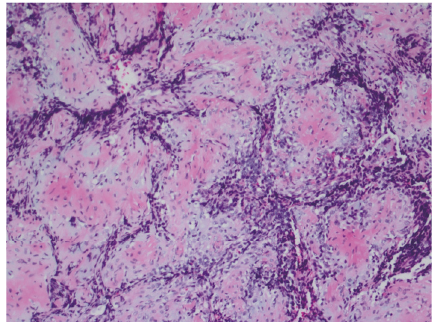
Figure 3: 10x magnification of chondroid portion.